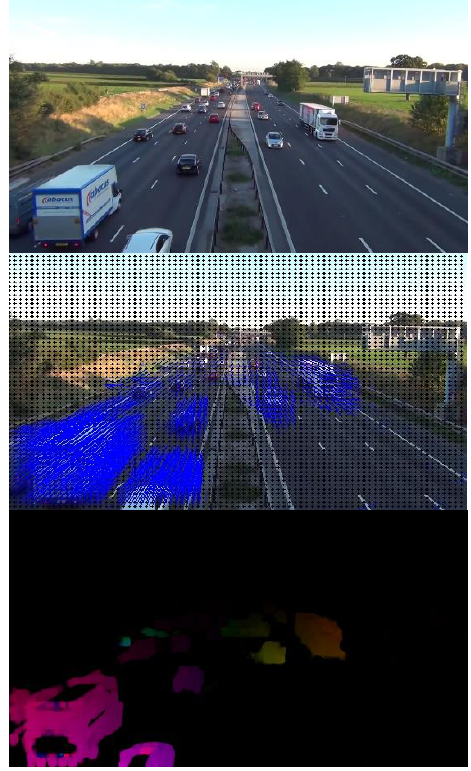
Figure 13. Estimated optical flow on real road traffic video .